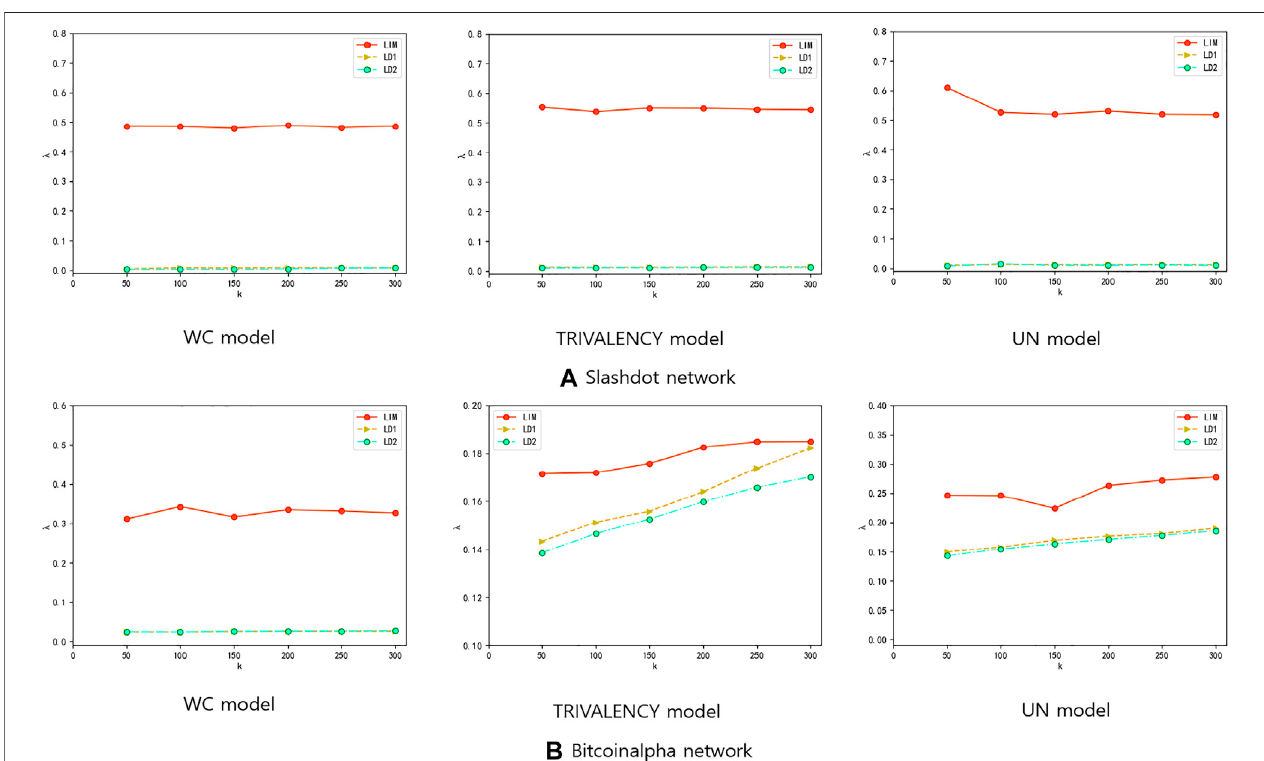
FIGURE6| ResultComparisonsbetweenLIMandLD1andLD2whenapplyingon (A) Slashdotdataset (B) Bitcoinalphadataset.Theexperimentsareconducted on (A) Slashdotnetwork (B) Bitcoinalphanetwork.Three diffusionprobabilitymethods areconsidered,i.e., WC model, TRIVALENCY model, and UNmodel. Forthe UN model, the probability value we set is 0.03. In each experiment, parameter k means that k seeds are selected to activate other nodes. And λ means the proportion of positivelyactivatedtargetnodesamongallactivatednodes.RankingmethodsincludeLocalDegree1(yellowtriangles),LocalDegree2(greencircles),andLIM(red circle) methods. The results in each fi gure are obtained by averaging over 2,000 independent